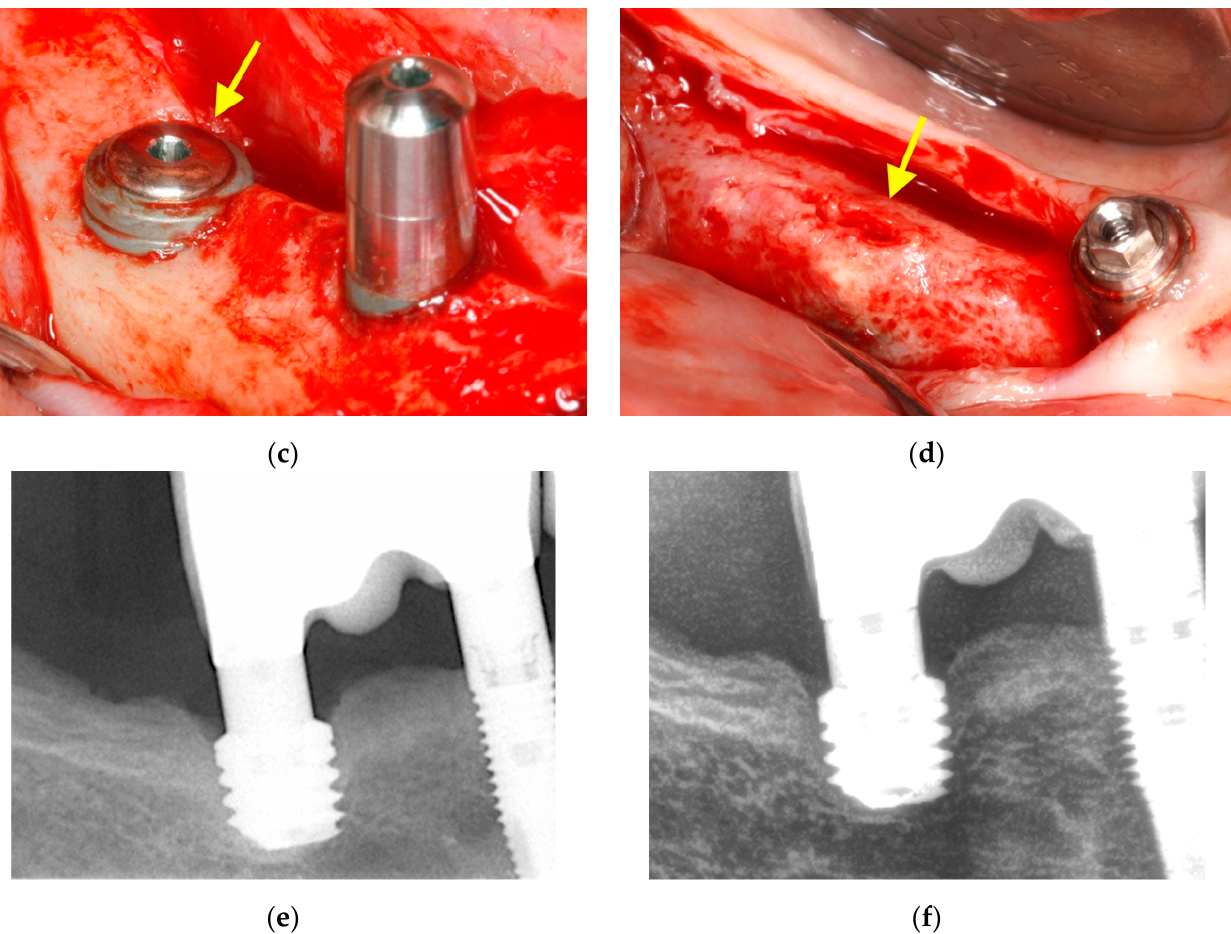
Figure 7. Vertical bone atrophy in the jaw with a residual bone height of 4 mm ( a ). Insertion of the dental implant leaving a part of the implant exposed, which was covered using bone recovered from the site preparation mixed with PRGF-Endoret ® ( b , c ). At 4 months ( d , e ), vertical bone regeneration can be observed covering the implant (yellow arrow). Stability of the regenerated bone at 5 years follow-up ( f ).